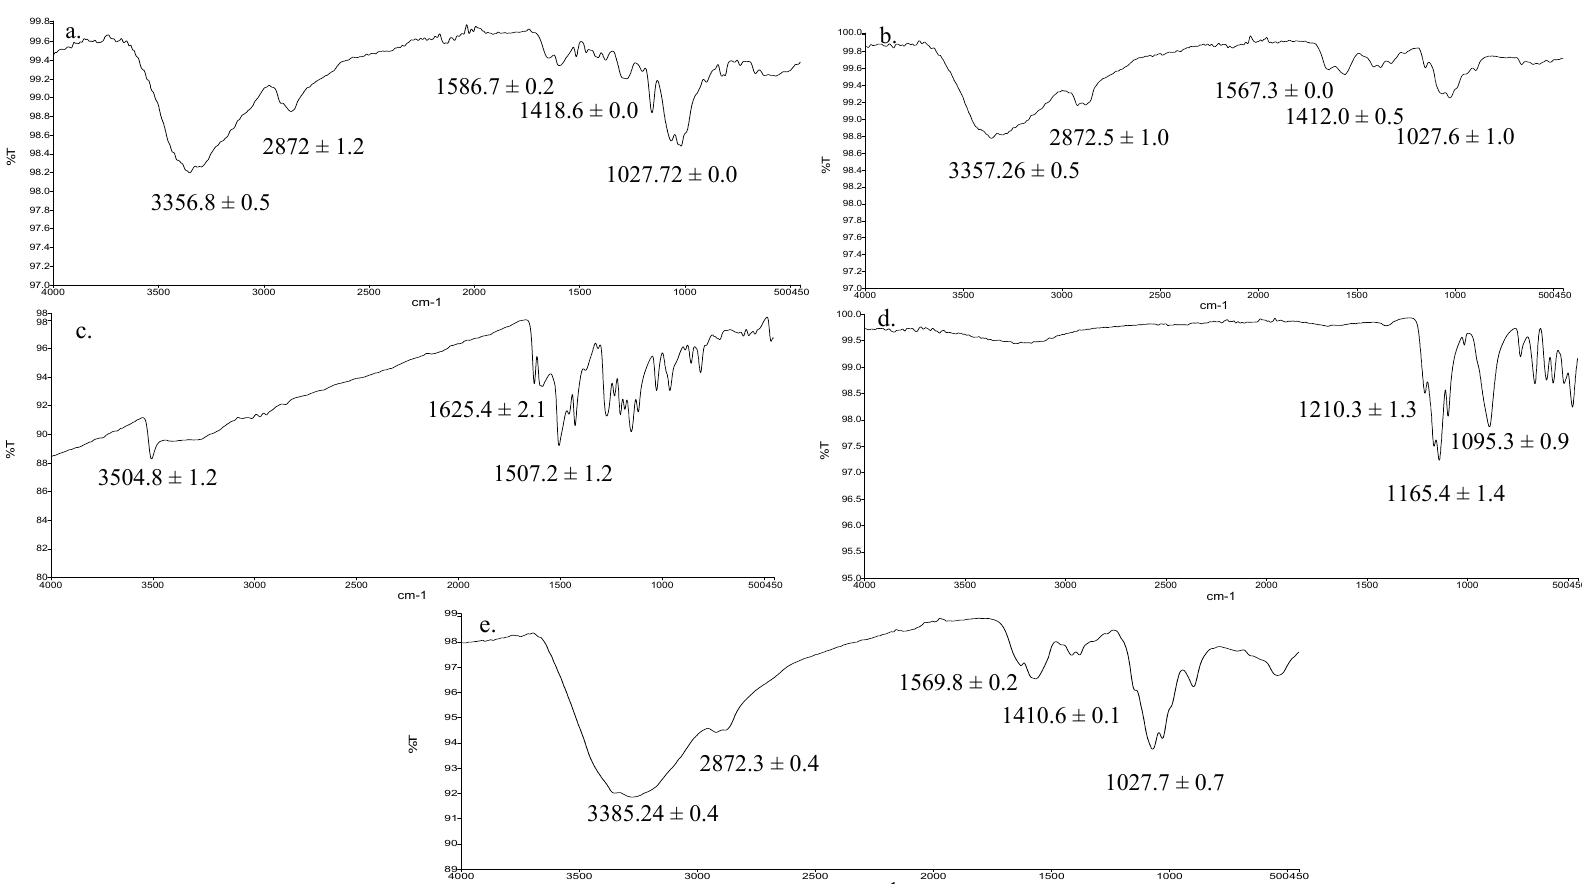
Figure 3. ATR-FTIR spectra of ( a ) high molecular weight (HMW) chitosan, ( b ) LMW chitosan, ( c ) pure curcumin, ( d ) tripolyphosphate (TPP), ( e ) formulation (F2) nanoparticles.